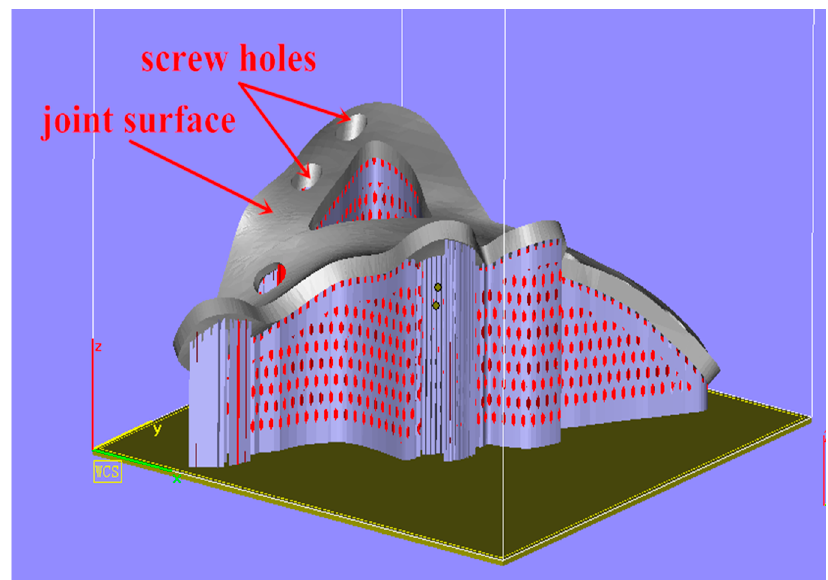
Figure 5. Orientation placement of the customized bone plate and addition of support (Magics 16.0).